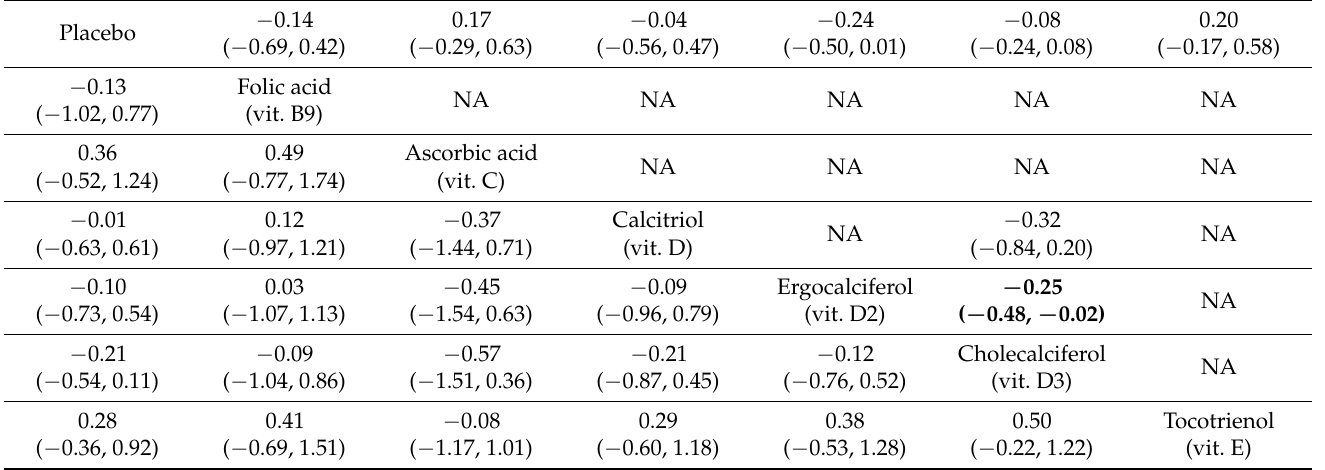
Figure 2. Network of available comparisons between different types of oral vitamin supplements in arterial stiffness. Table 2. Pooled mean differences in different types of oral vitamin supplements on arterial stiffness.